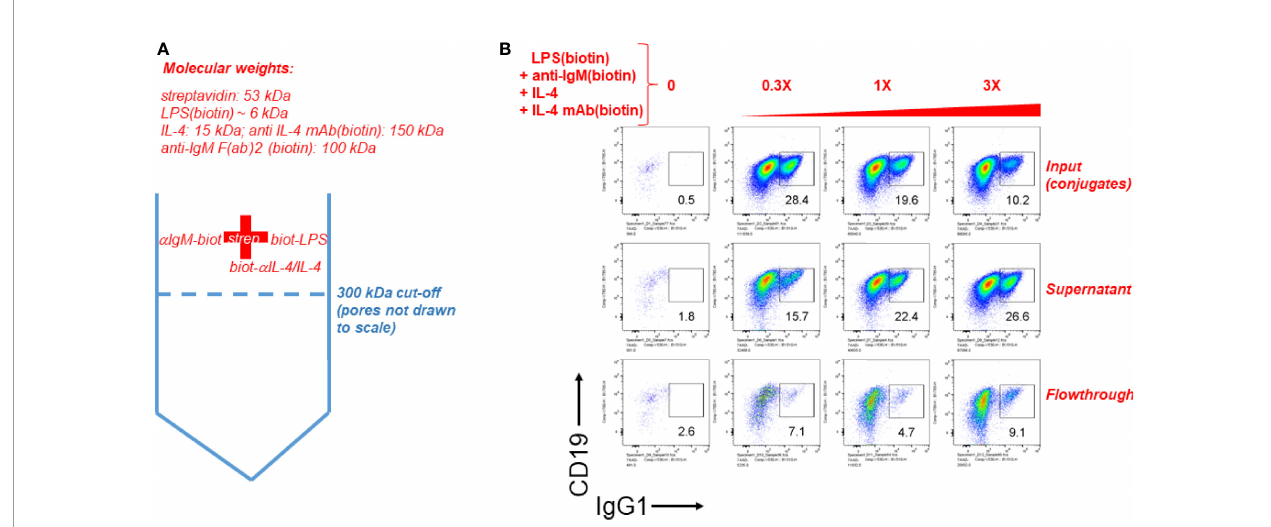
FIGURE 6 | Streptavdin-biotin immunoconjugates must be over 300 kDa according to molecular sieve fi ltration followed by cell stimulation. (A) Schematic of the experiment to fi lter streptavidin:biotin B cell immunoconjugates through a molecular sieving centrifugal fi lter unit with 300 kDa MW cut-off membrane pores. Since IL-4 is essential for B cell growth and CSR to IgG1 it was tethered by its biotinylated antibody at a 1:1 ratio. (B) Biotinylated LPS (3 m g/ml), biotinylated anti-IgM F(ab ’ ) and fl ow-though were collected. The supernatant volume was brought to be equal to the volume of fl ow-through by adding DPBS. Next, equal volumes of input, supernatant and fl ow-through were added to splenocyte cultures at 0, 0.3X, 1X, and 3X, where 1X refers to the initial concentration of each component in the input. CSR to IgG1 after 4 days of stimulation reveals that most of the CSR-inducing activity is retained in the supernatant, but is lost in the fl